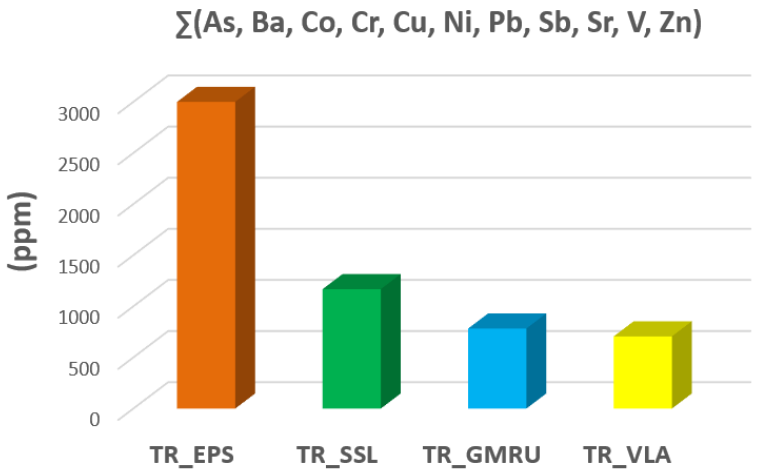
Figure 7. Total amount of trace elements (ppm) in the analyzed tremolite asbestos from Episcopia (TR_EPS), San Severino (TR_SSL), and tremolite asbestos from Gimigliano – Mount Reventino Unit, Calabria (TR_GMRU) and Val d’Ala, Piedmont (TR_VLA) studied by Bloise et al. [15,16] and showed for comparison.